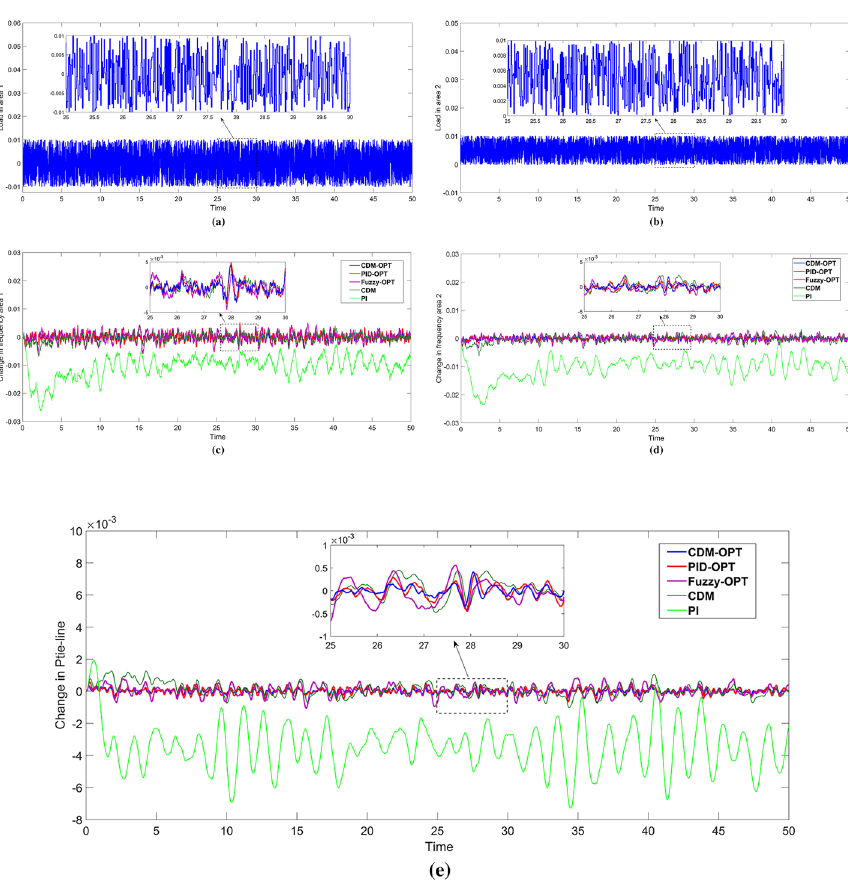
Fig. 7 Case 4 Signals: a Random load in area 1. b Random load in area 2. c Frequency in area 1. d Frequency in area 2. e Tie-line between